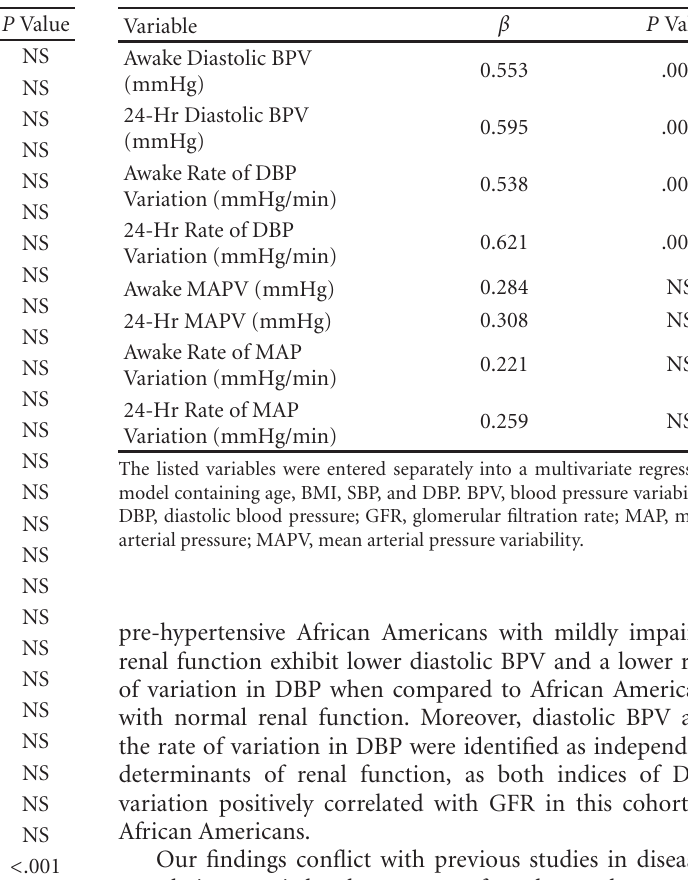
Table 3: Univariate regression analyses predicting GFR. Table 4: Multivariate regression analyses predicting